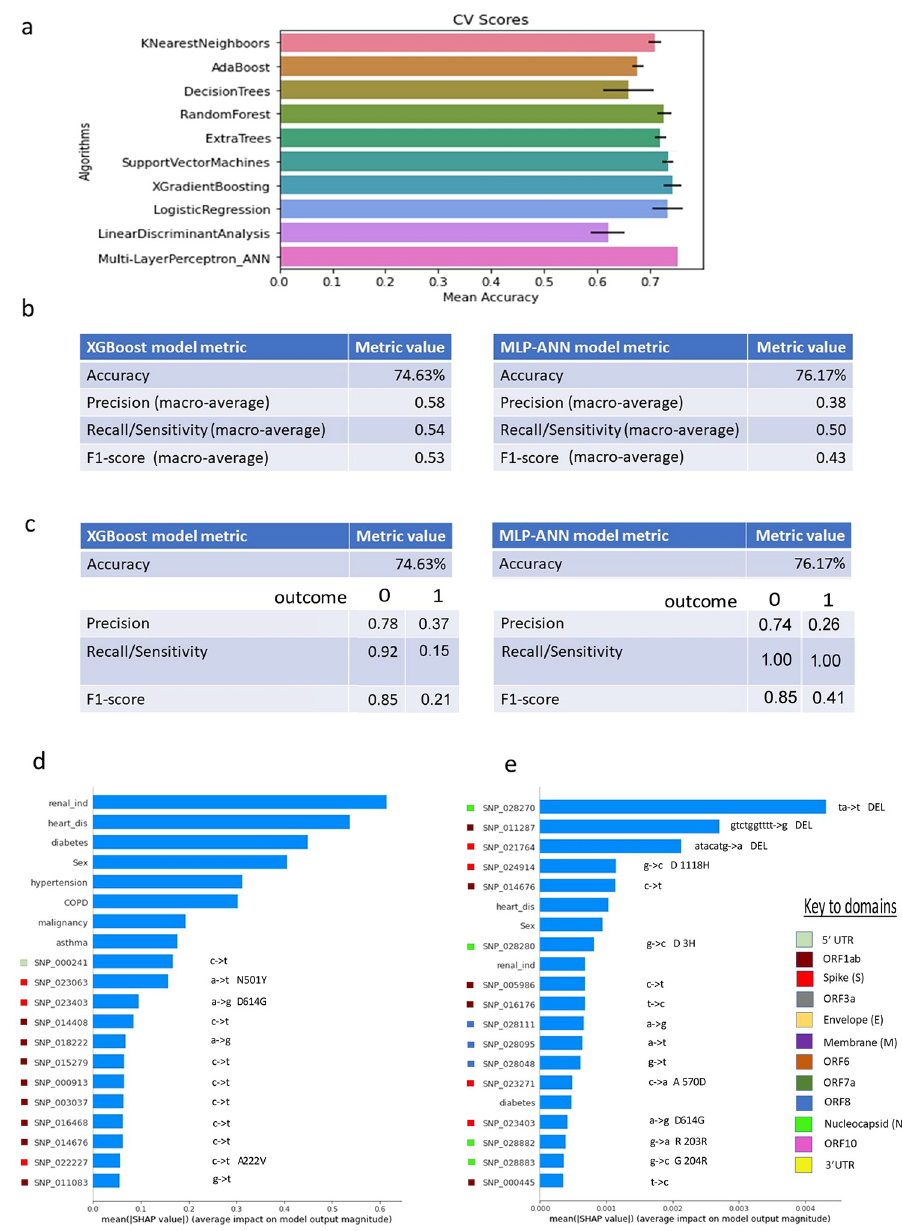
Fig 5. Machine learning and artificial neural network analysis of mutations in the SARS-CoV2 genome isolated from patients with COVID-19. (a) Screening and comparison of nine machine-learning and one deep-learning multi-layer perceptron artificial neural network (MLP-ANN) method showing mean percentage accuracy of prediction of outcome; death (1) or no death (0). Error bars shown represent standard deviation of accuracy run over 200 estimators (machine-learning) or 300 epochs for neural-net analysis. (b) Macro-average (where metrics for outcomes 1 and 0 are averaged) metrics comparison between the XGBoost and the MLP-ANN method. The MLP-ANN gave better macro-average accuracy metrics. (c) Individual metrics shown for outcomes 1 (death) and 0 (no death), compared between XGBoost and MLP-ANN models. The MLP-ANN gave better accuracy metrics and overall Sensitivity metrics. (d) Ranking of SNPs and clinical parameters in order of importance, displayed according to their SHapley Additive exPlanations (SHAP) values in their predictive ability in the respective models. The location of the SNPs in relation to the SARS-CoV2 genome is based on mapping to the reference genome (Wuhan-Hu-1, GenBank, MN908947.3) and shown using colour-coded keys. Also shown are the nucleotide changes noted in relation to each